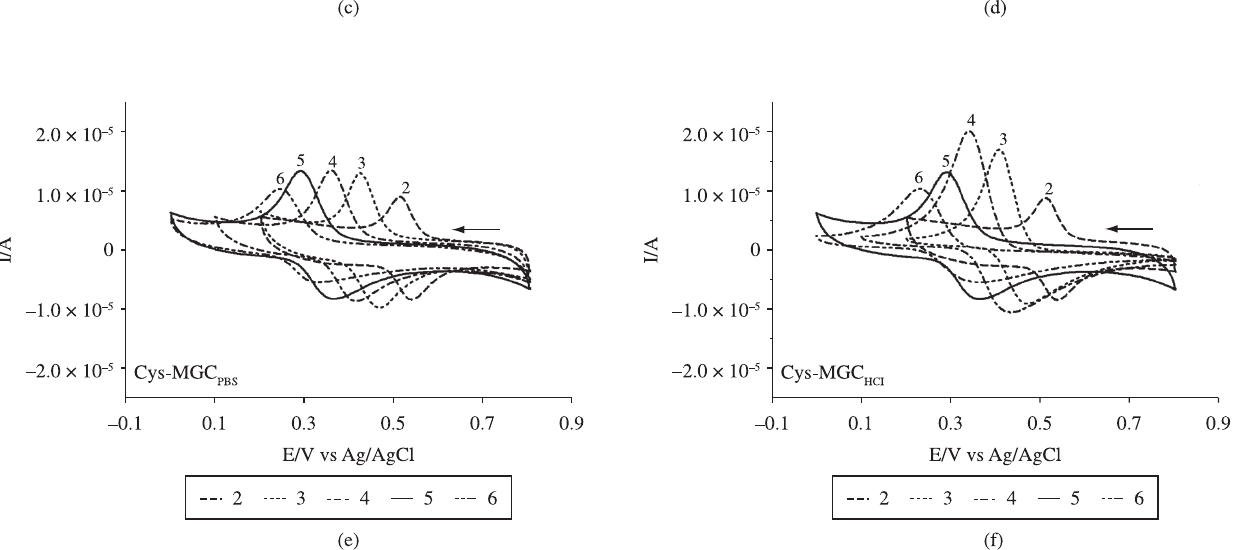
Figure 4. Effect on CV current peaks of DA at Cys-MGC electrodes (Cys-MGC recorded in a series of buffer solutions: phthalate (a and b); acetate (c and d) and phosphate (e and f). The solution concentration was 200 μ L of 0.01M DA in 25 mL, scan rate of 100 mV/s and at 25